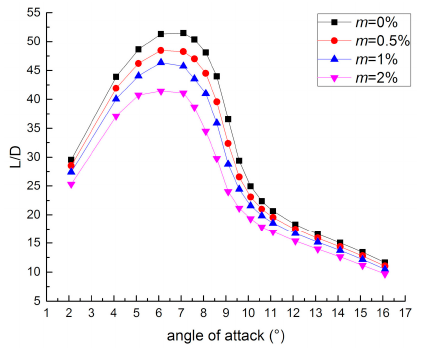
Figure 12. Particle concentration effects on lift-to-drag ratio of S809 airfoil at Re = 1 × 10 6 .